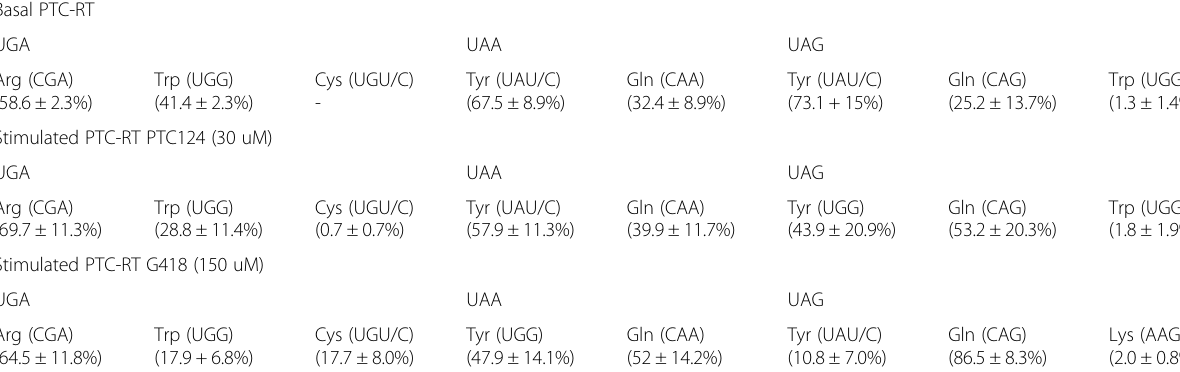
Table 1 Amino acids inserted during readthrough Basal